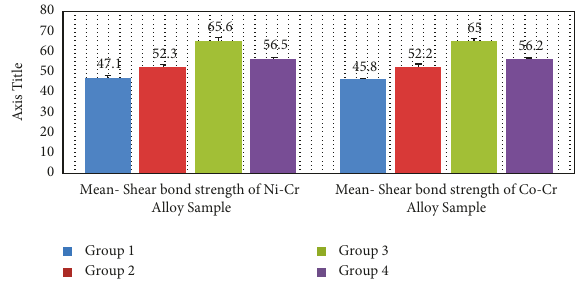
Figure 3: Standard deviation error